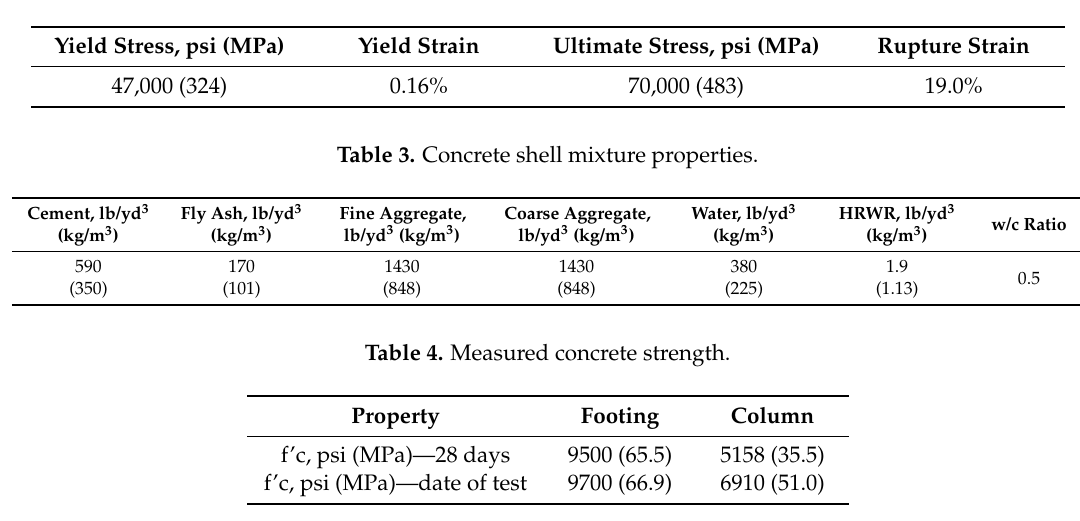
Table 2. Mechanical properties of the steel tube.